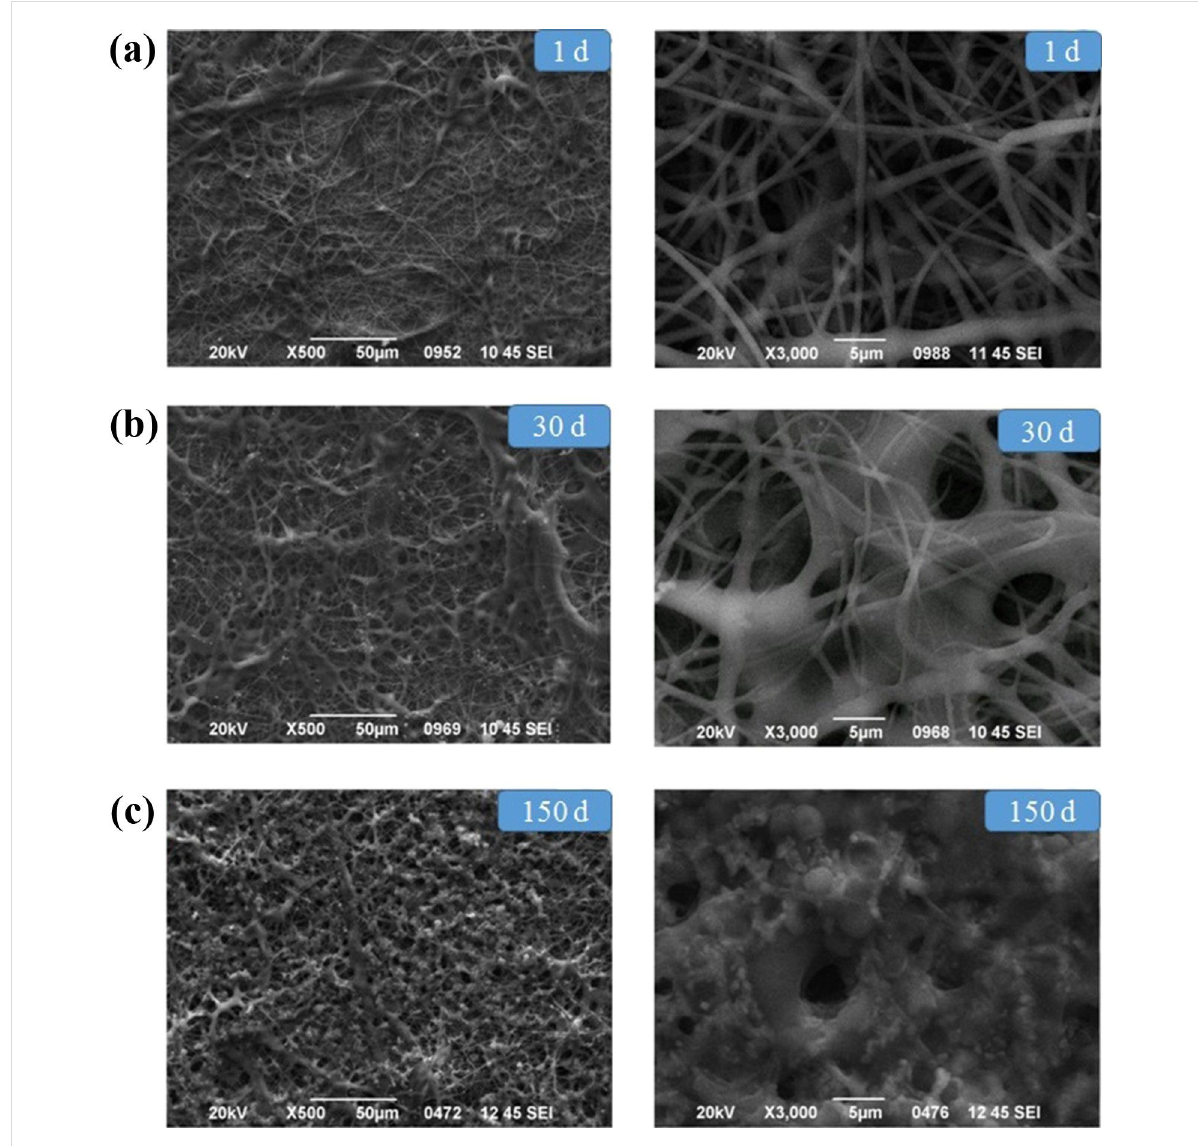
Figure 6: Representative SEM micrographs of CA scaffolds (a) before degradation on the 1st day, (b) after degradation in vitro for 30 days, (c) after degradation in vitro for 150 days. The mean diameters of the CA fibers after day 1 and day 30 were 1756 and 4078 nm,